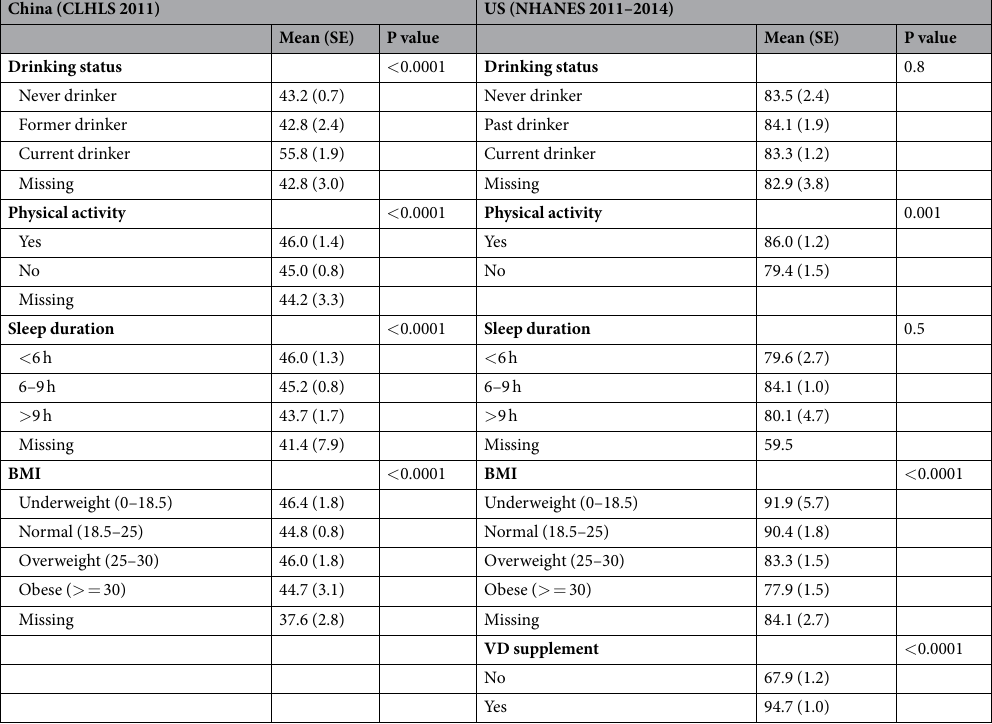
Table 2. Serum 25(OH)D levels by baseline characteristics among CLHLS and NHANES